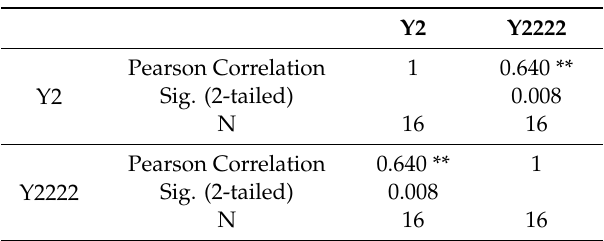
Figure 14. Normal P–P plot regression standardized residuals. Table 10. Correlations between Y2 and